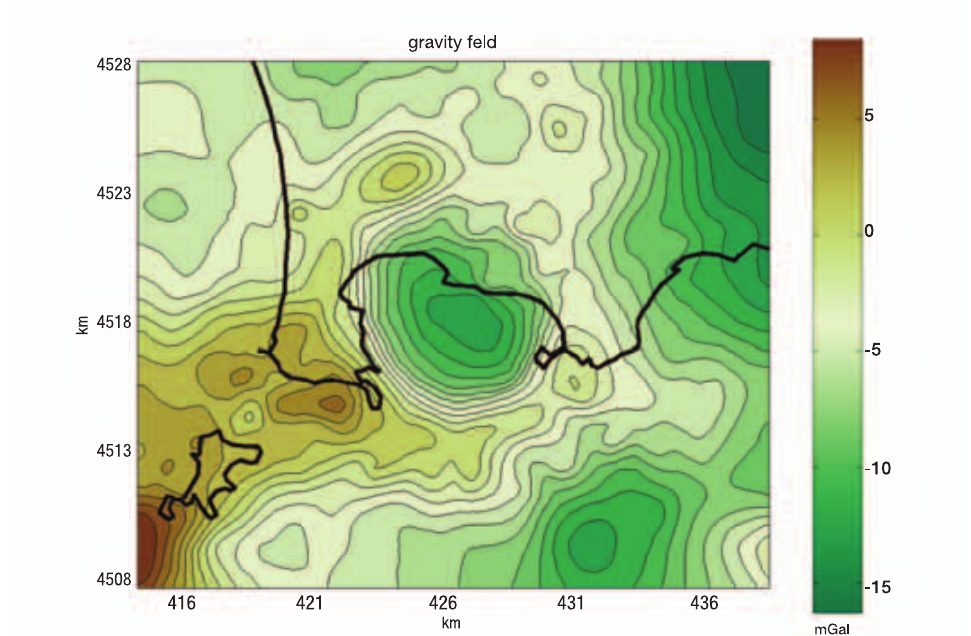
Fig. 7a. Bouguer gravity anomaly field (step grid = 0.15 km) in the Phlegrean Fields (near Naples,